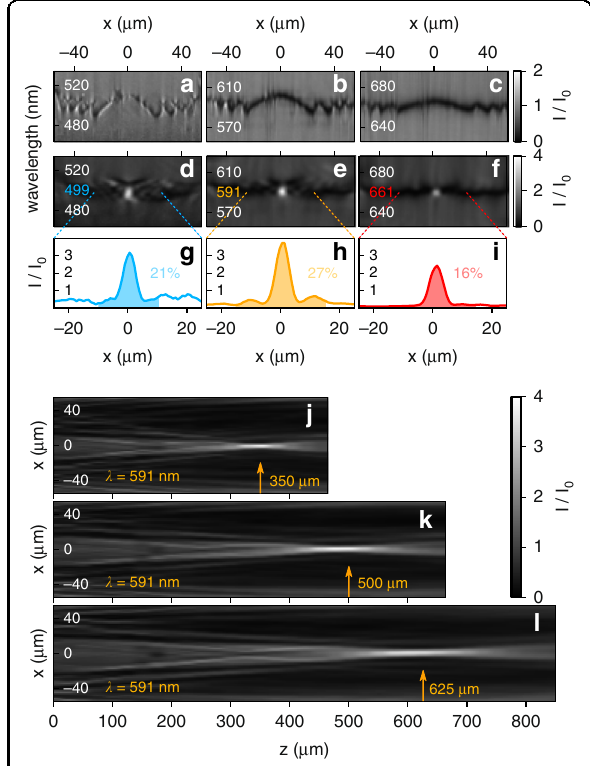
Fig. 5 Programmable lensing with the FP-SLM. a – c Measured spatially resolved near-zone (z = 0) re fl ectance spectra as a function of the transverse position in the device. The plots show tailored resonance positions, imparting phase pro fi les to achieve focusing to the same focal distance for the three operating wavelengths. d – f Measured spatially resolved re fl ectance spectra at z = 525 μ m, showing the resulting focal spots with maximum ef fi ciencies at 499 nm, 591 nm and 661 nm wavelengths. g – i Line pro fi les of the focal spots at the wavelengths indicated in ( d – f ). Focusing ef fi ciencies corresponding to the shaded areas are 21%, 27% and 16%, respectively. j – l Measured intensity distributions as a function of the distance to the device ( z ) for the orange wavelength of 591 nm. Recon fi gurable change of focal distance is demonstrated for